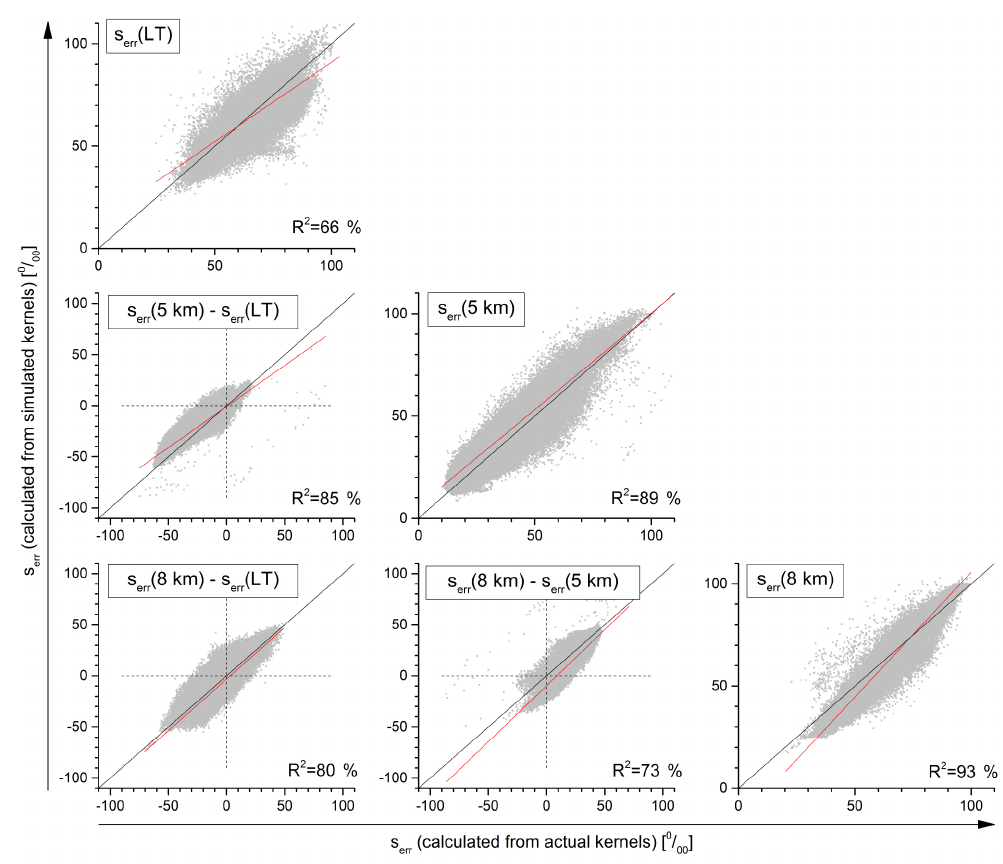
Figure 7. Evaluation of the simulated sensitivity error matrix S err (calculation of S err according to Eq. 7). Compared are of the square roots of the diagonal elements ( s err ) as obtained from the actual and the simulated kernels. The legends indicate the six different s err products that are compared in the six different panels.